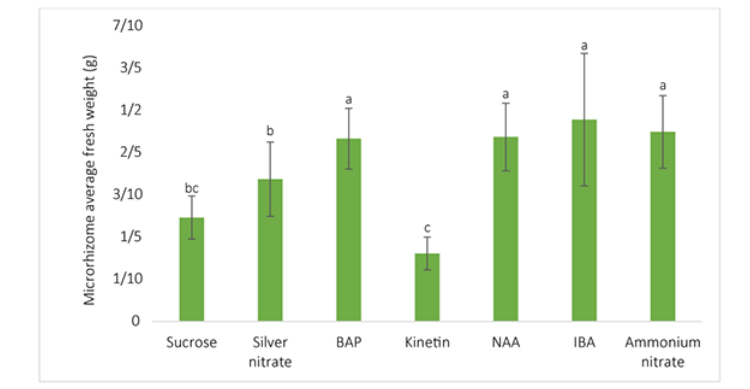
Figure 5 Maximum average fresh weight comparison among the tested factors at their optimal concentrations being 80 g/L sucrose, 1.9 mg/L AgNO 3 , 4 mg/L BAP (6-benzylamino purine), 6 mg/L kinetin, 6 mg/L NAA ( α -naphthaleneacetic acid), 4 mg/L IBA (indole- 3-butyric acid), and 550 mg/L NH 4 NO 3 . The nonsignificant difference of the four maximum average fresh weight values of 4 mg/L BAP, 6 mg/L NAA, 4 mg/L IBA, and 550 mg/L NH 4 NO 3 indicated that MS media supplemented with those four factors are all the best media for the induction of the heaviest ginger microrhizomes [the values shown in the bar charts are mean ± t (29) × SE , where t (29) is the upper 0.025 critical value for the t distribution with 29 degrees of freedom; means having a letter in common are not significantly different at the 5% level by Duncan’s test].